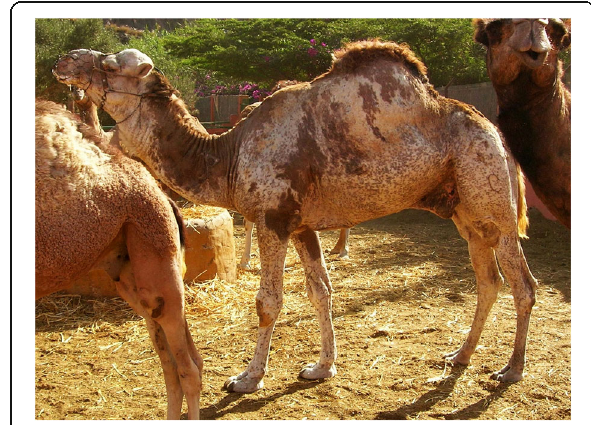
Figure 3 A camel bull of the Canary Islands showing a complex piebald pattern and speckled markings (Dioli